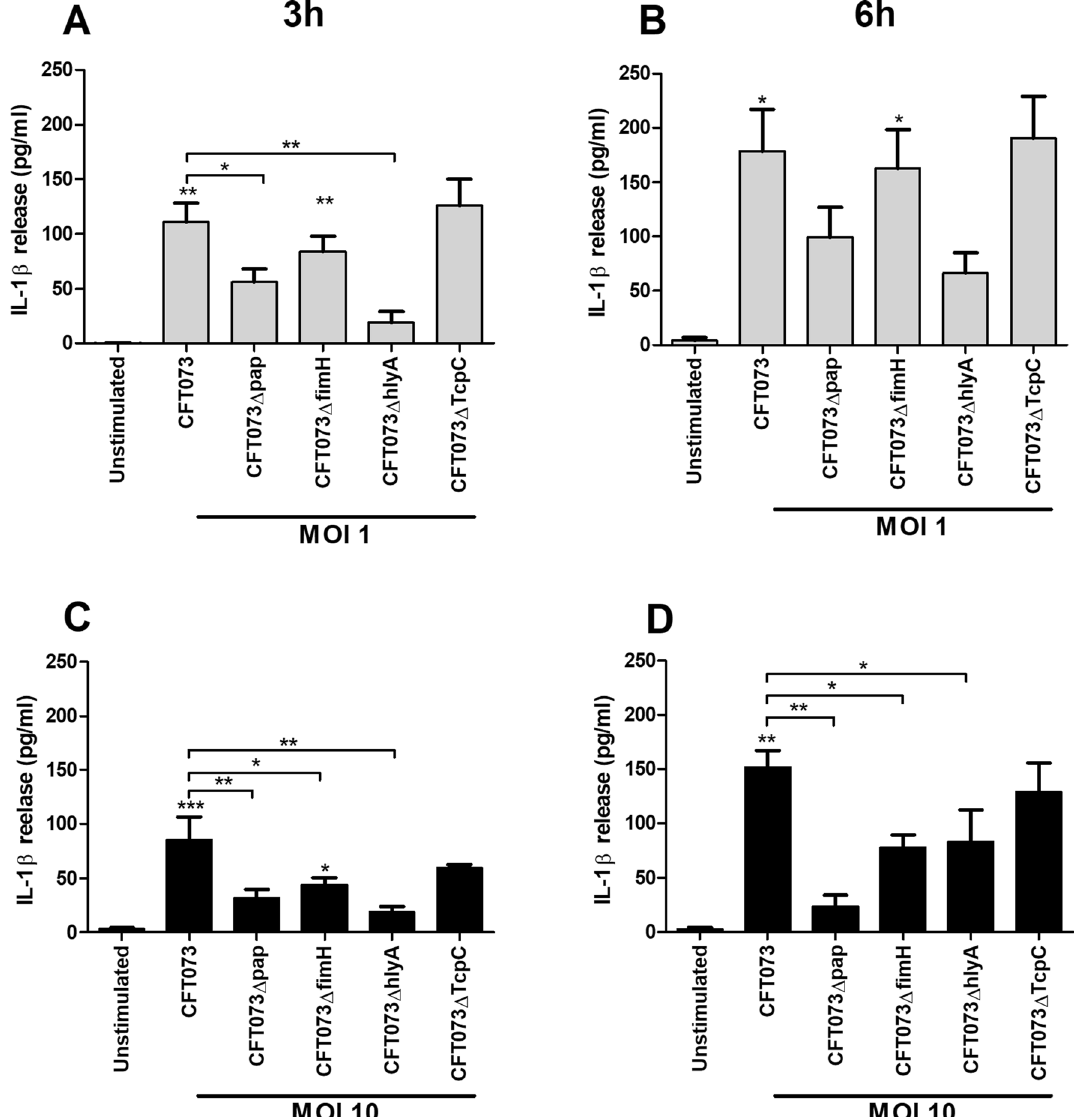
Figure 5. UPEC virulence factors associated with IL-1β release. Neutrophils were infected with UPEC strain CFT073, CFT073Δ pap , CFT073Δ fimH, CFT073Δ TcpC or CFT073Δ hlyA at MOI 1 ( A , B ) or MOI 10 ( C , D ) for 3 h ( A , C ) and 6 h ( B , D ) followed by analysis of IL-1β release. Data are presented as mean ± SEM (n = 3 independent experiments). Asterisks over bars denote statistical significance compared to respective unstimulated control (*p < 0.05, **p < 0.01, ***p <